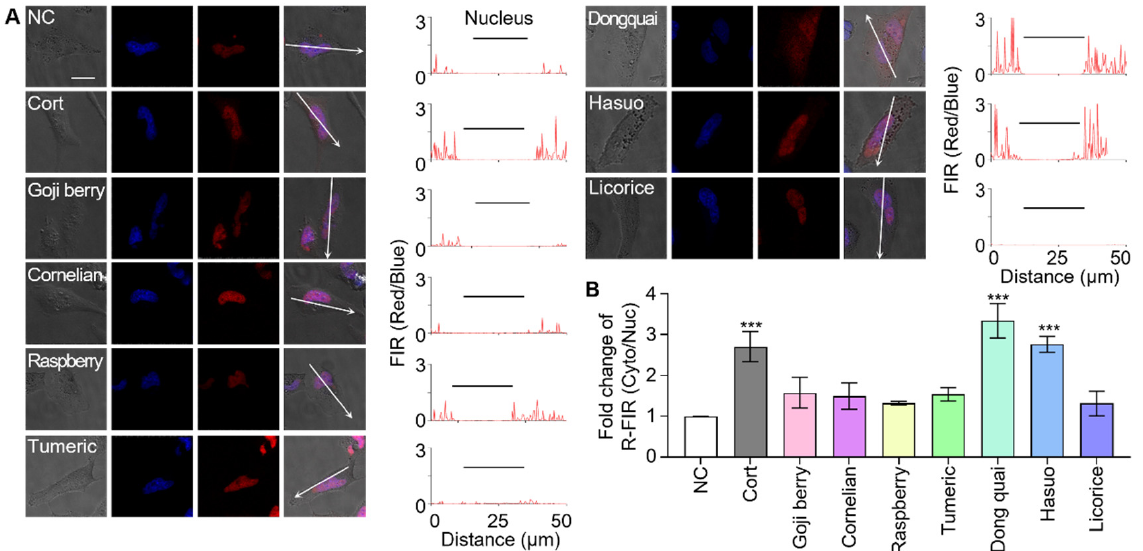
Figure 5. Screening medicinal plant extracts using sensor cells. ( A ) The sensor cells were individually challenged with seven different extracts of medicinal plants. The sensor cells responded to dongquai and hasuo extracts (scale bar = 20 µ m). ( B ) Fold change in the ratio of red fluorescence intensity from the cytoplasm to that of the nucleus (R-FIR Cyto/Nuc) over untreated control sensor cells is calculated. Data were analyzed by one-way ANOVA using the Tukey multiple comparison test (* p < 0.05, ** p < 0.01, *** p < 0.001).